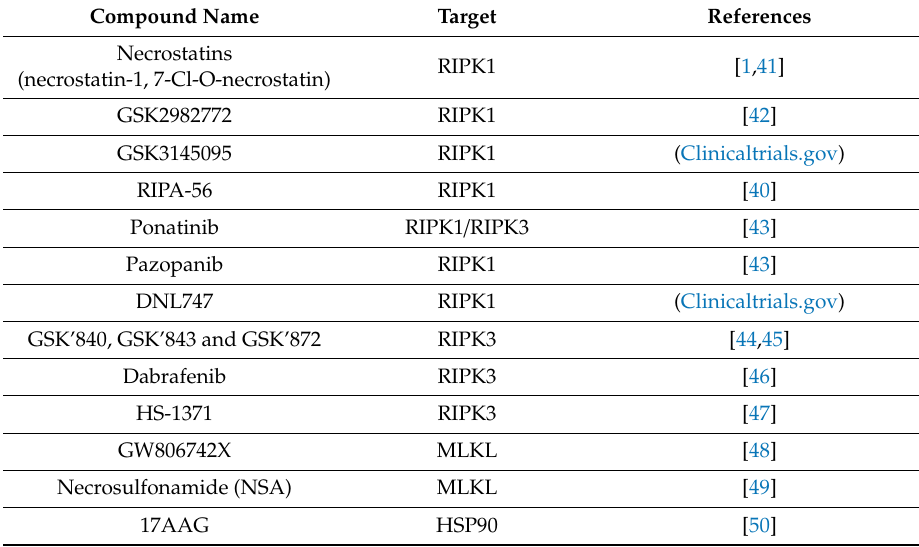
Table 2. Necroptosis